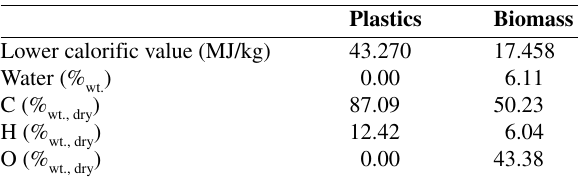
Plastics Biomass